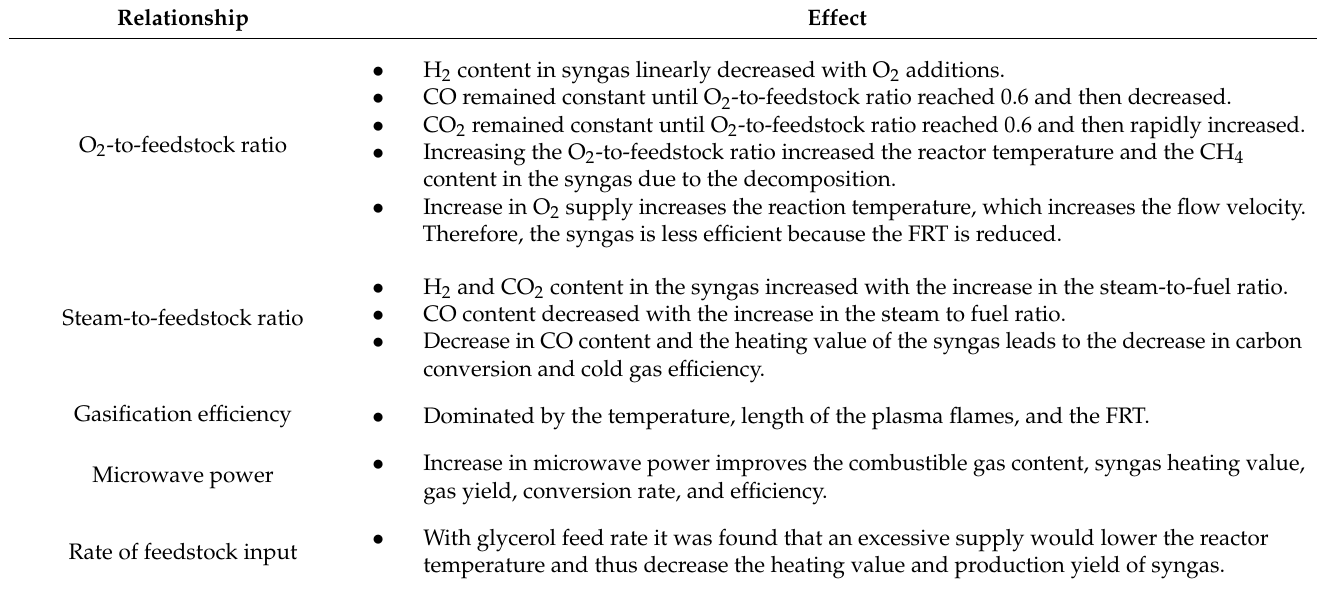
Table 4. Reactor kinetic relationships and effects from Yoon et al.’s